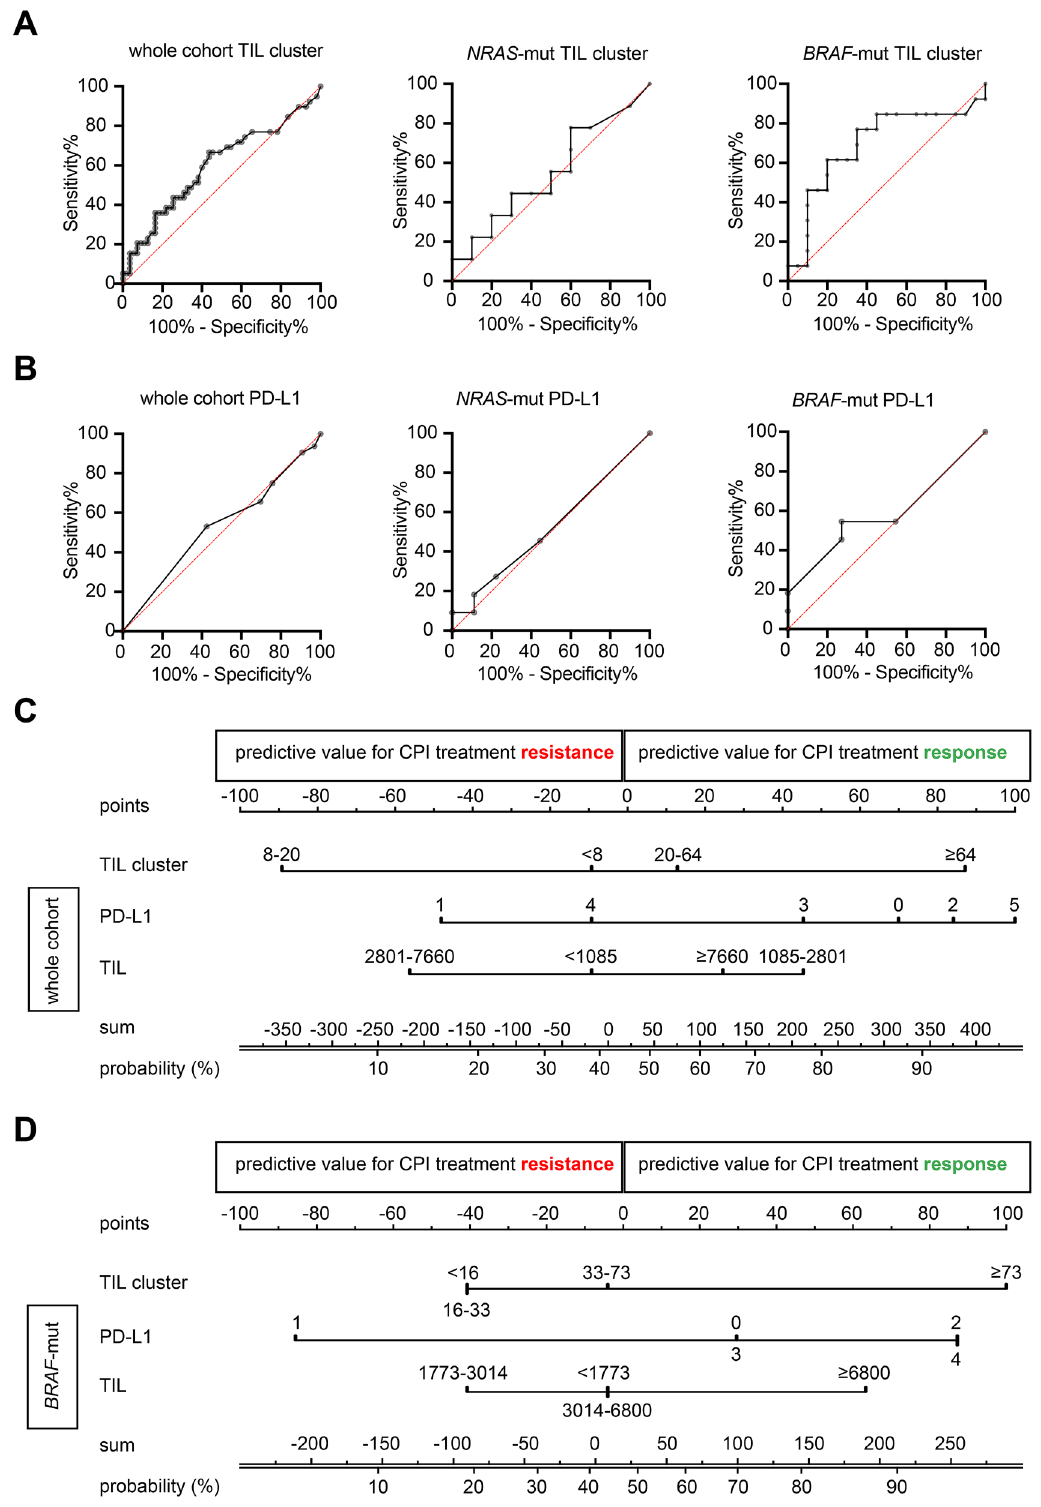
Figure 2. Predictive value of TIL clusters in malignant melanoma subsets. Overview of predictive value of TIL clusters according to molecular subtypes of malignant melanoma using individual ROC curves and a nomogram combining several attributes and their predictive value to predict response to CPI treatment. ( A ) Area under the curve for TIL clusters for different mutation types of MM tumors ( BRAF -mut; BRAF V600 E/K ). ( B ) Area under the curve for PD-L1 scoring for different MM mutation subtypes. ( C ) Nomogram for the whole cohort of MM patients (n = 90). ( D ) Nomogram for the BRAF -mutated ( BRAF -mut; BRAF V600 E/K ) sub cohort (n = 32) of MM patients. The positive values (points) indicate the prediction towards responses, while negative values reflect the predictive value for therapy